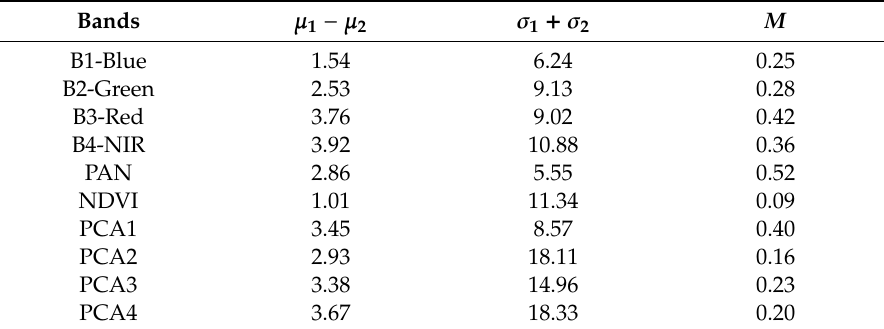
Table 4. M -statistic for linear traces of GH in